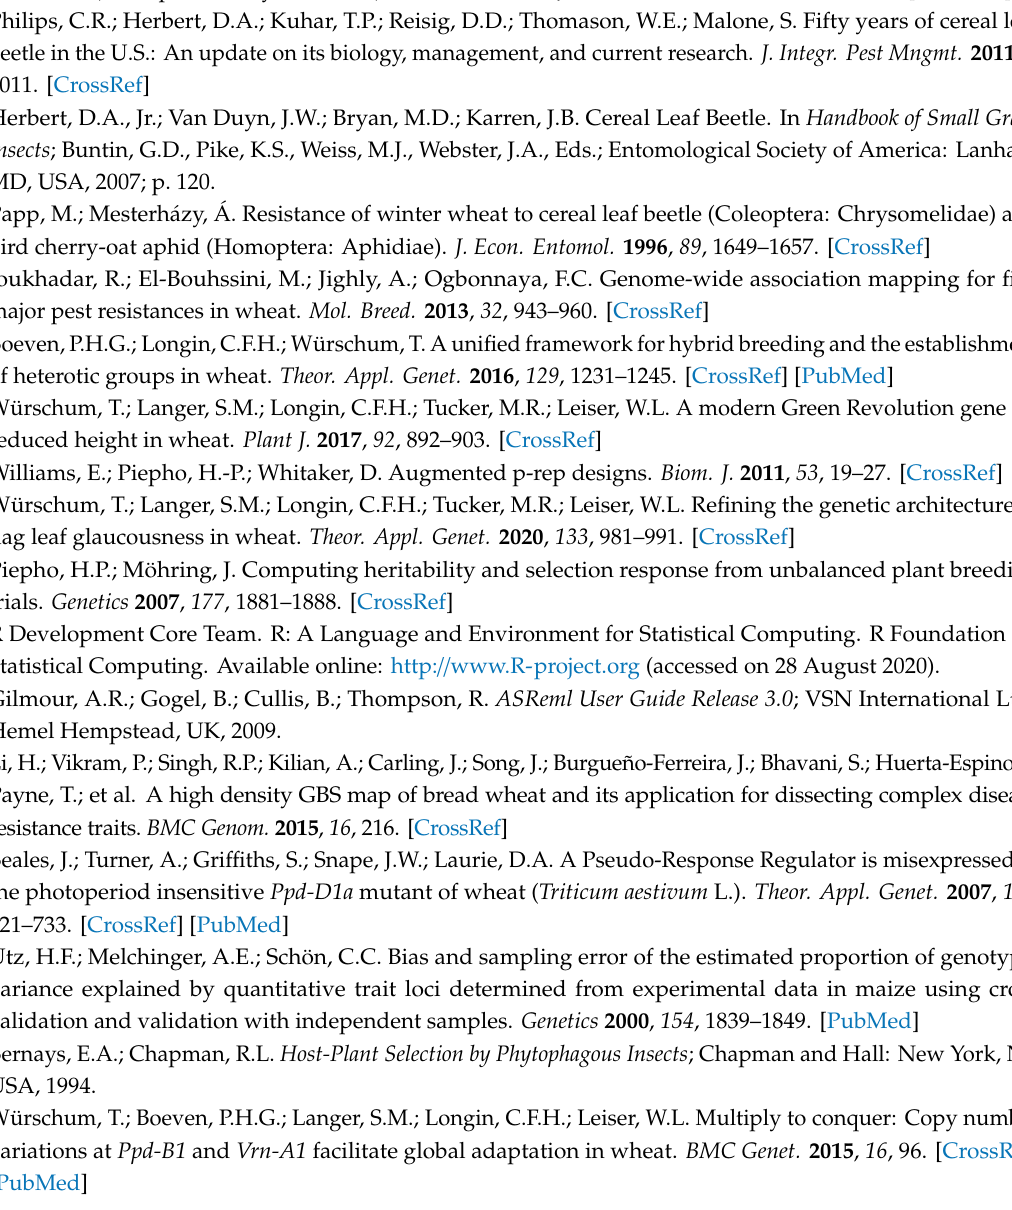
Table S1: Summary statistics for cereal leaf beetle (CLB) susceptibility, Table S2: Assessment of the putative QTL identified in the full data set in the photoperiod sensitive Ppd-D1b and photoperiod insensitive Ppd-D1a subsets, Figure S1: Cereal leaf beetle (CLB) infestation in the field, Figure S2: Results from location